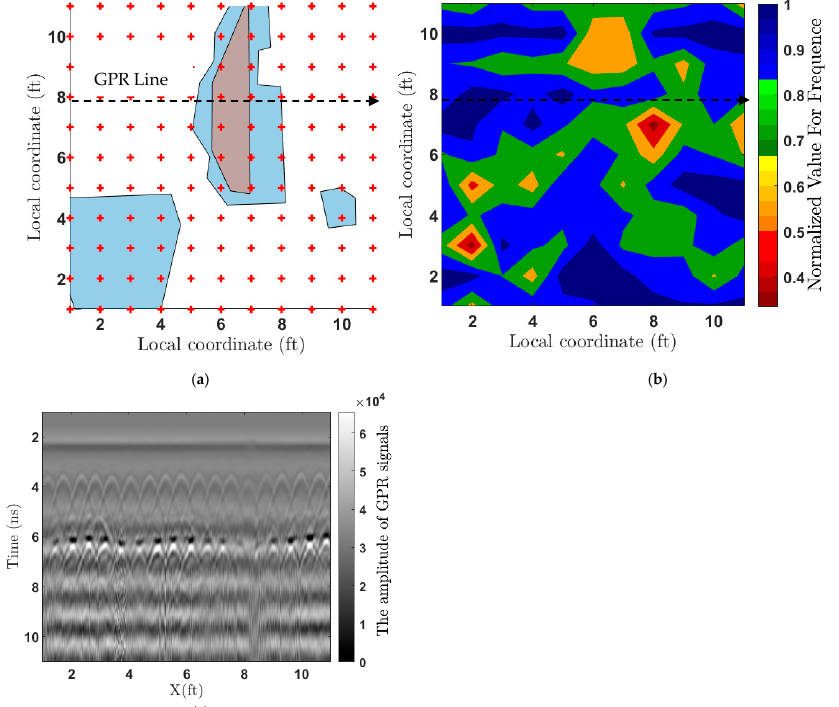
Figure 17. FR NB origin B ( a ) ground truth, ( b ) frequency approach, and ( c ), B scan of the GPR Data (local coordinate Y = 6). In addition, the GPR data were validated by plotting the signals from the portions of the deck showing rebar corrosion and section loss with the signals for the sound portions of the deck. Strong rebar reflection represents sound concrete, while weak rebar reflection indicates deterioration [21]. Figure 18 shows three (3) signals each of class 1 (1A, 1B, and 1C-sound concrete), class 2 (2A, 2B, and 2C), and class 3 (3A, 3B, and 3C-sound concrete), delaminated and corroded rebar regions, while Figure 19 shows the corresponding im- ages of the exposed regions during inspection used for validating GPR signals.